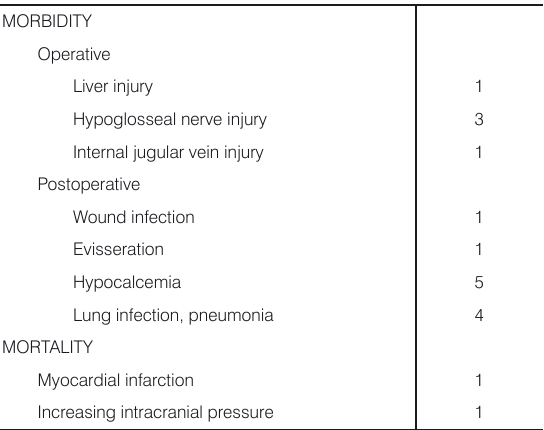
Table 3. Dispertion of the complications that caused morbidity and mortality (n=13).